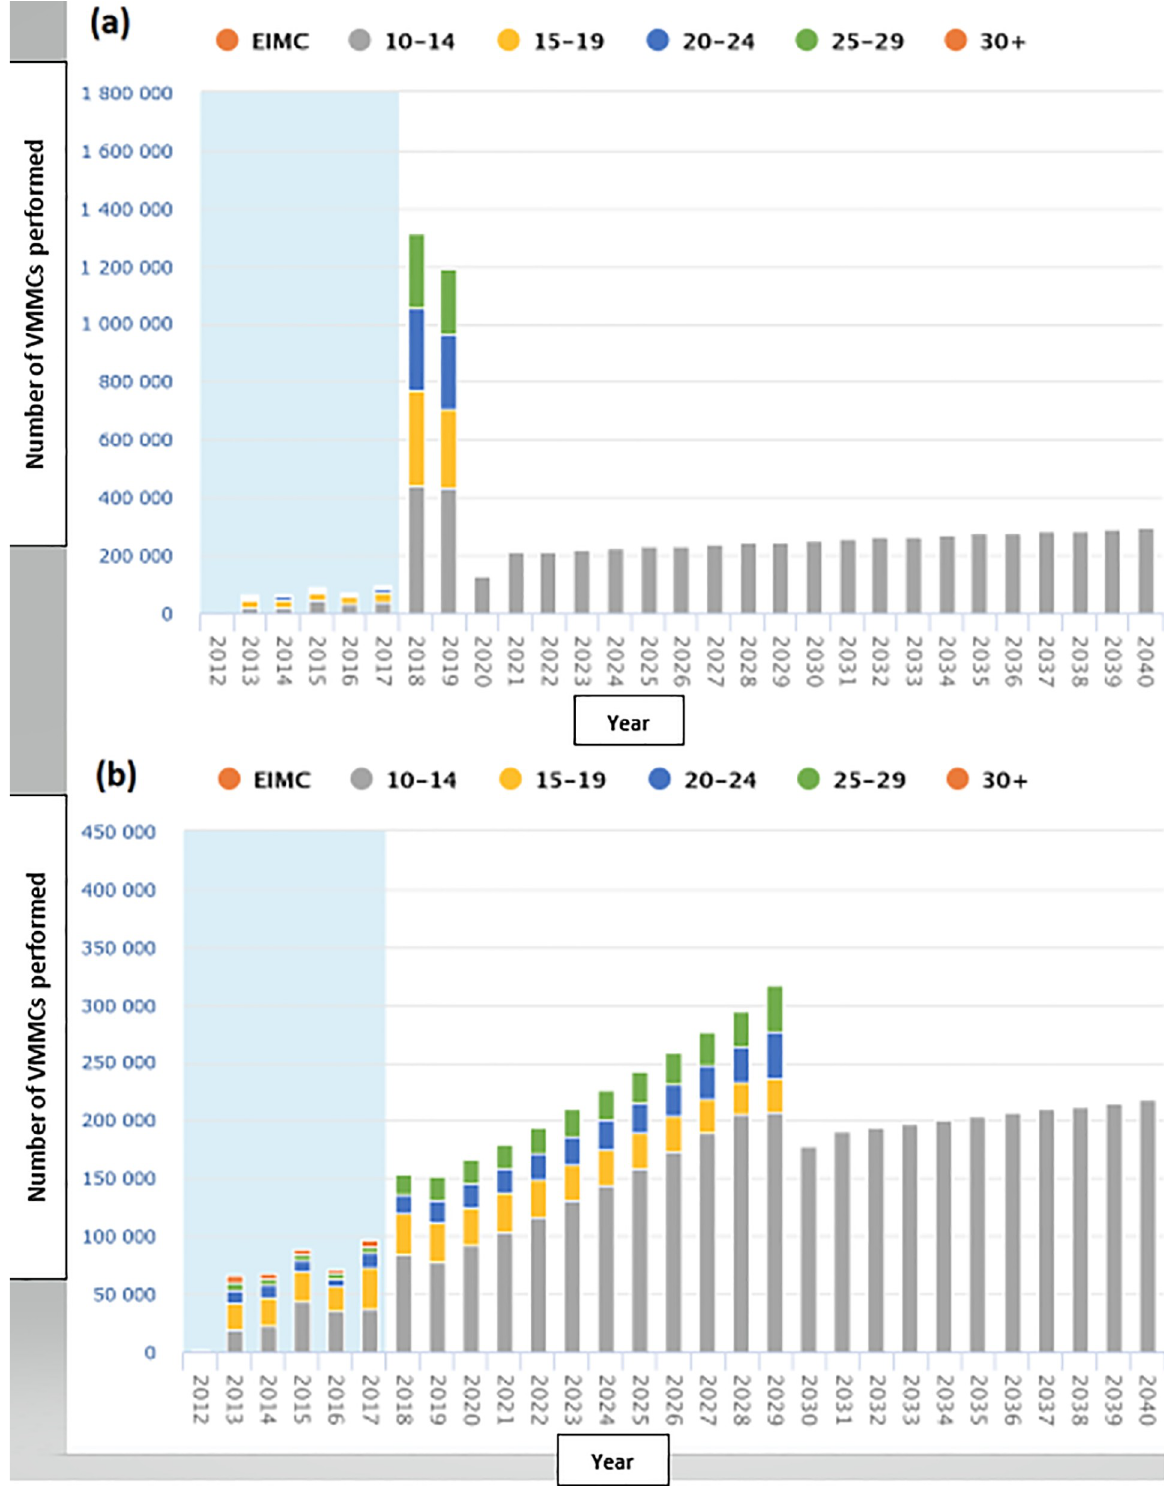
Fig 1. Result visualization #1 for hypothetical scale-up scenarios: Number of VMMCs required for: (a) scale-up to 80% coverage among males age 10–29 years by 2020, (b) scale-up to 60% coverage among males age 10–29 years by 2030.